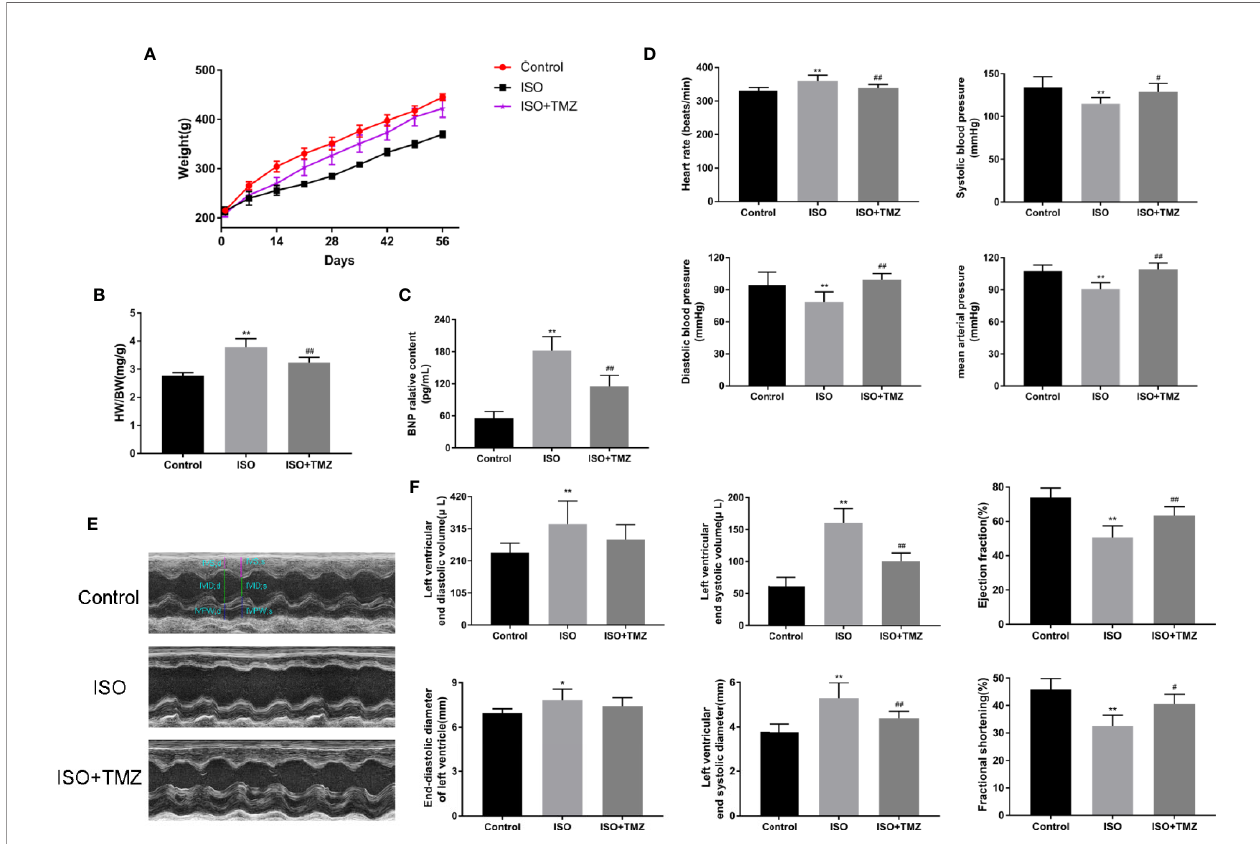
FIGURE 1 | Trimetazidine improves the general condition and cardiac function of rats in the isoproterenol-induced HF model. (A) Bodyweight changes of rats in each group (n = 10). (B) Changes in rat heart weight index for different groups (n = 10). (C) B-type natriuretic peptide levels in sera were detected by enzyme linked immunosorbent assay (n = 6). (D) Heart rate, systolic blood pressure, diastolic blood pressure, mean arterial pressure of rats in each group (n =6). (E) Representative M-mode echocardiograms for different groups. (F) The histogram showed left ventricular end-diastolic volume, left ventricular end-systolic volume, and left ventricular ejection fraction. Left ventricular end-diastolic diameter, left ventricular end-systolic diameter and left ventricular fractional shortening (n = 6) were also shown. Data are represented as mean ± SD, # P < 0.05, ## P < 0.01 compared with ISO group, *P < 0.05, **P < 0.01 compared with control